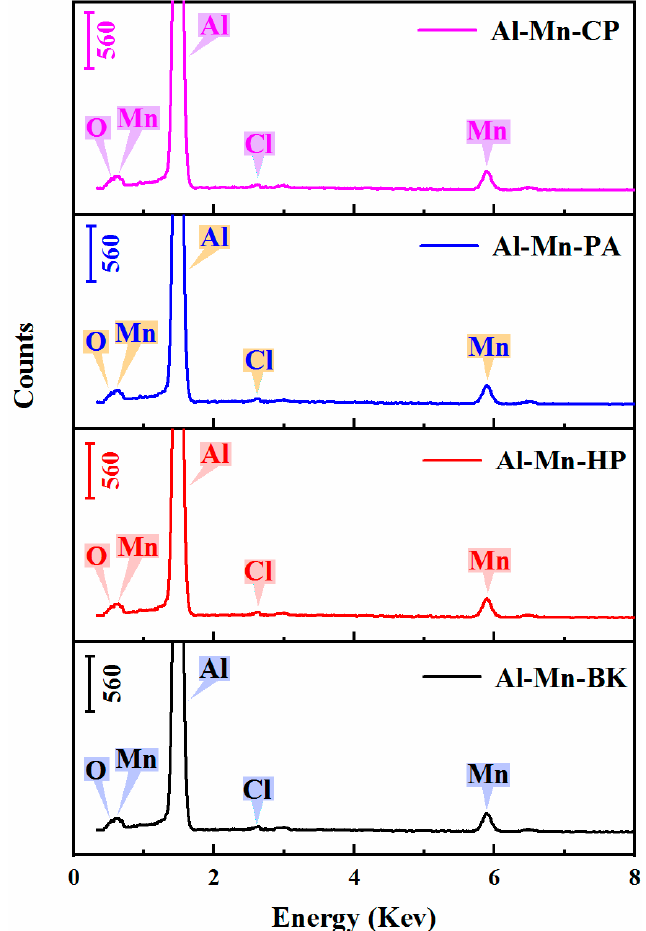
Figure 3. EDS spectrum of various electrodeposited Al-Mn coatings. From bottom to top are the EDS spectra of the Al-Mn-BK, Al-Mn-HP, Al-Mn -PA, and Al-Mn-CP coatings. Table 1. Elemental compositions of various Al-Mn coatings obtained from the EDS spectra in Figure 3. Element